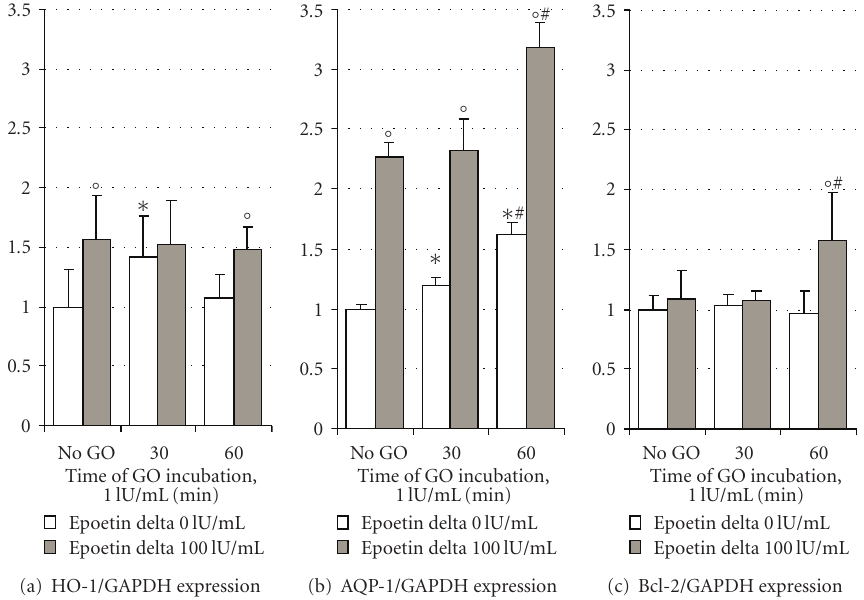
Figure 5: Quantitative real-time RT-PCR analysis of HO-1 (a), AQP-1 (b), and Bcl-2 (c) expressions in mixed hTECs under basal conditions and after GO-induced oxidative stress (1IU/mL) either or not in the presence of epoetin delta (100IU/mL). GAPDH was used as endogenous control housekeeping gene. Preconditioning the cells with EPO resulted in a significant upregulation of HO-1 and AQP-1 mRNA. GO- induced oxidative stress further increased HO-1, AQP-1, and Bcl-2 mRNA expressions with maximum levels 60 minutes after induction of oxidative stress. Data are presented as the mean ± SD of triplicate determinations of 2 runs (i.e., 6 values each). ∗ P < . 05 versus no GO, ◦ P < . 05 versus epoetin delta 0 IU/mL, # P < . 05 versus 30 minutes GO